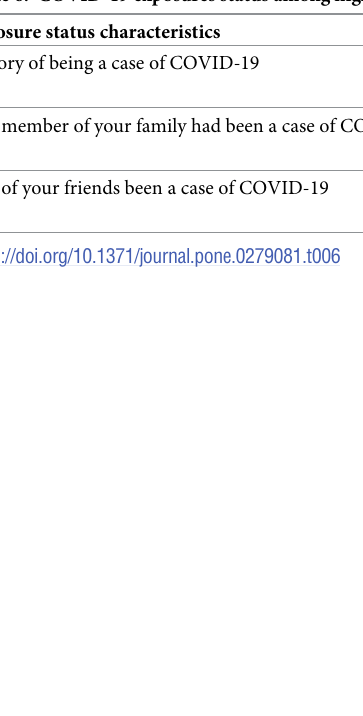
Table 6. COVID-19 exposures status among high school students of Jimma public high schools 2021 (n = 388).